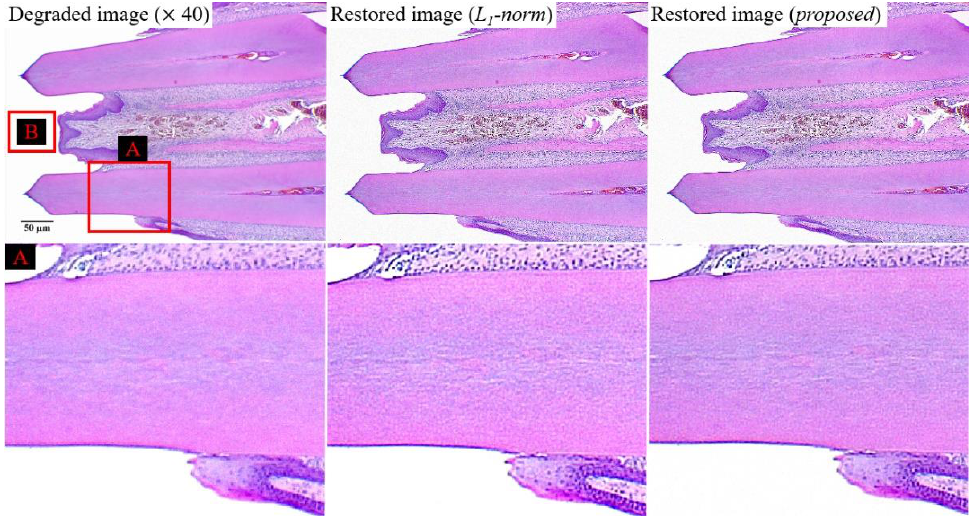
Figure 9. Experiment results for the degraded image (magnification of 40), restored image ( l 1 -norm-based), and image restored using the proposed method.